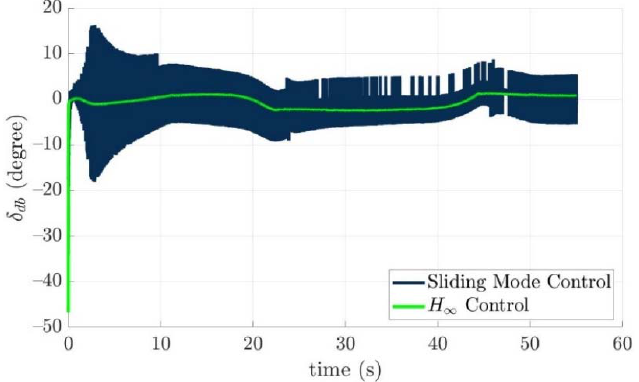
Figure 28. The downward bow rudder angles of the controlled torpedo-like underwater vehicle for two control laws, respectively.